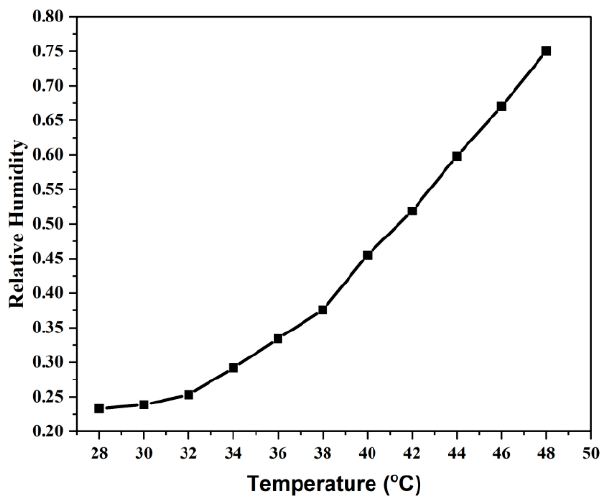
Figure 8. Corroboration between LM35 and hygrothermal data values.